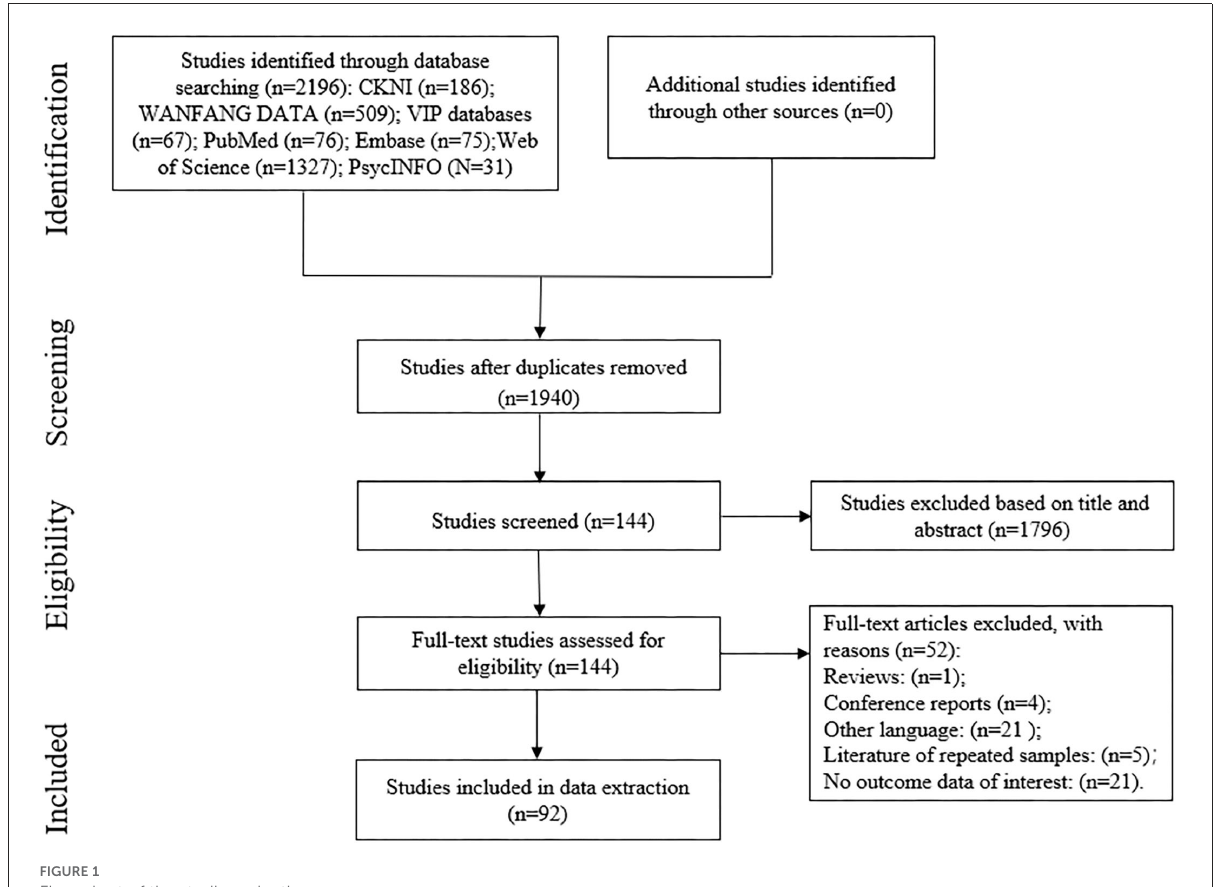
FIGURE1 Flow chart of the studies selection process.